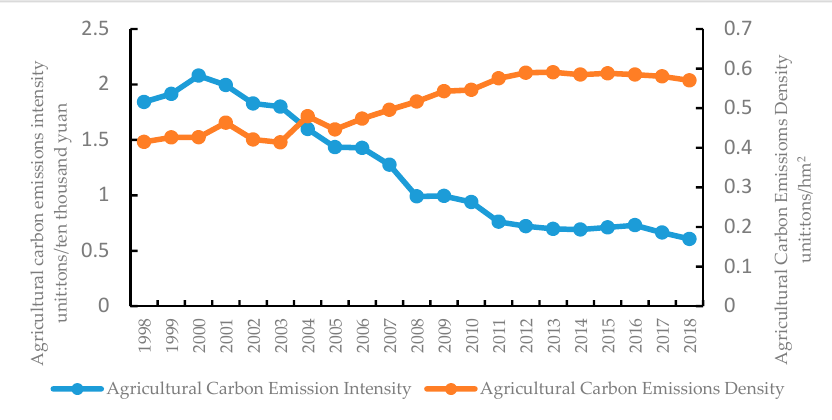
Figure 3. Intensity and density of agricultural carbon emissions in Jilin Province, China.